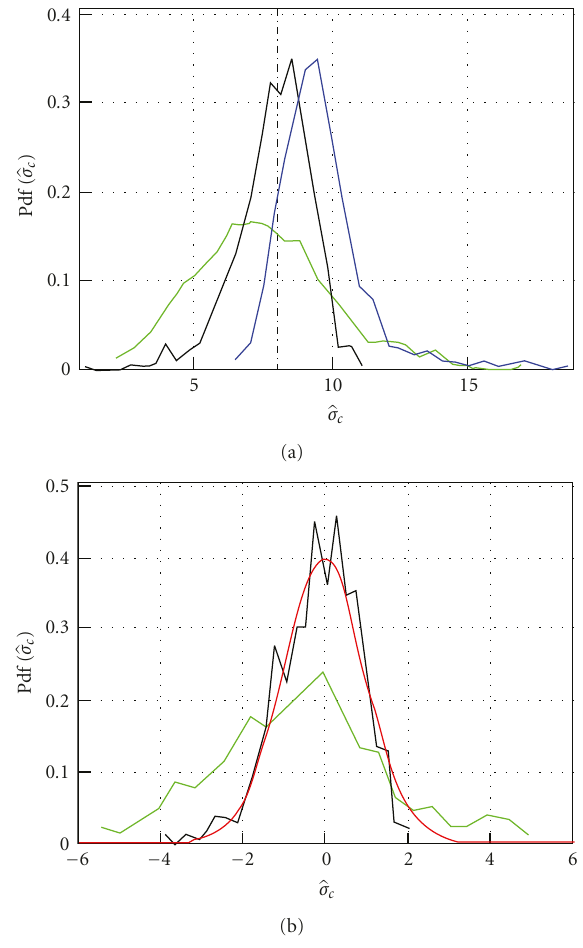
= 25 (blue curve), 65 n 0